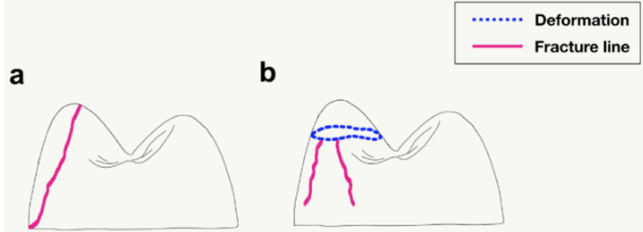
Figure 4. Two aspects of fracture after chipping test (sagittal view). ( a ) Fracture occurred from inner incline of cusp and spread downward along tooth wall. ( b ) Cusp tip was crushed and crack began around the